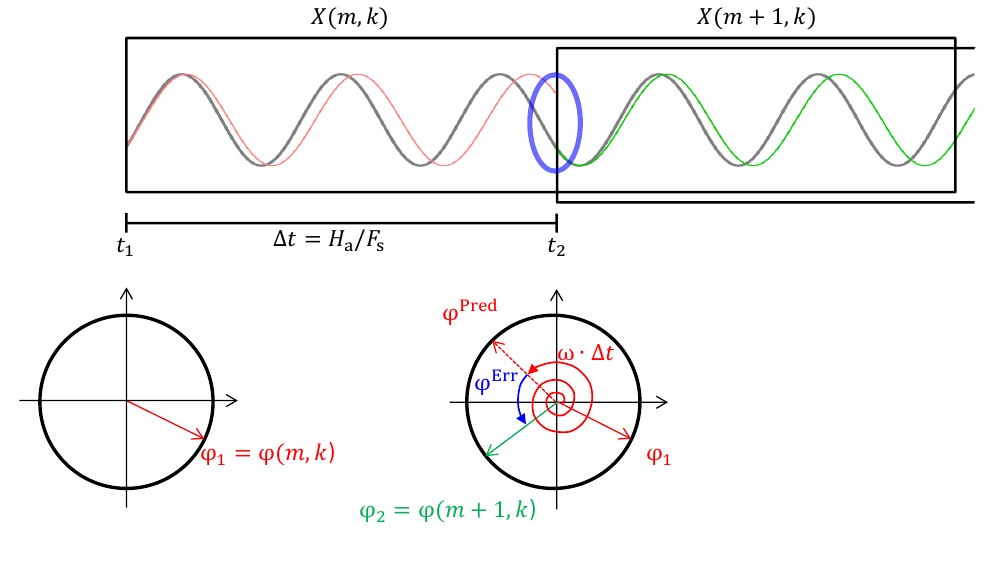
Figure 8. Principle of the phase